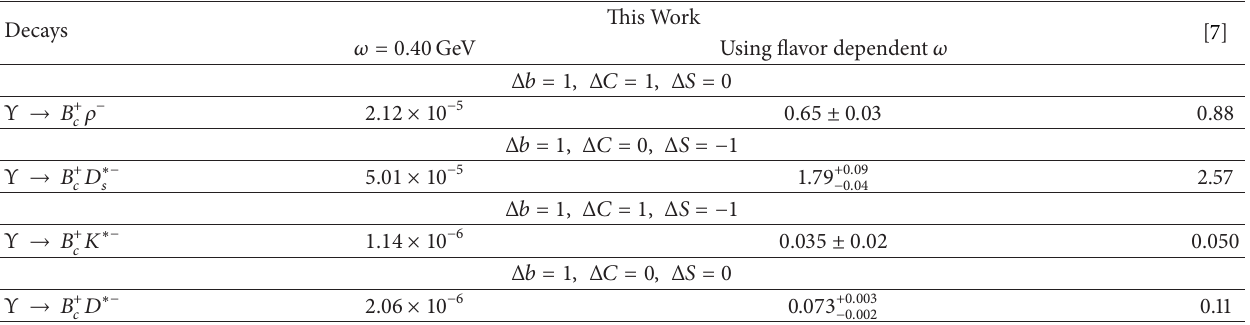
Table 12: Branching ratios (in the units of 10 −10 ) of Υ → 𝐵 𝑐 𝑉 decays.